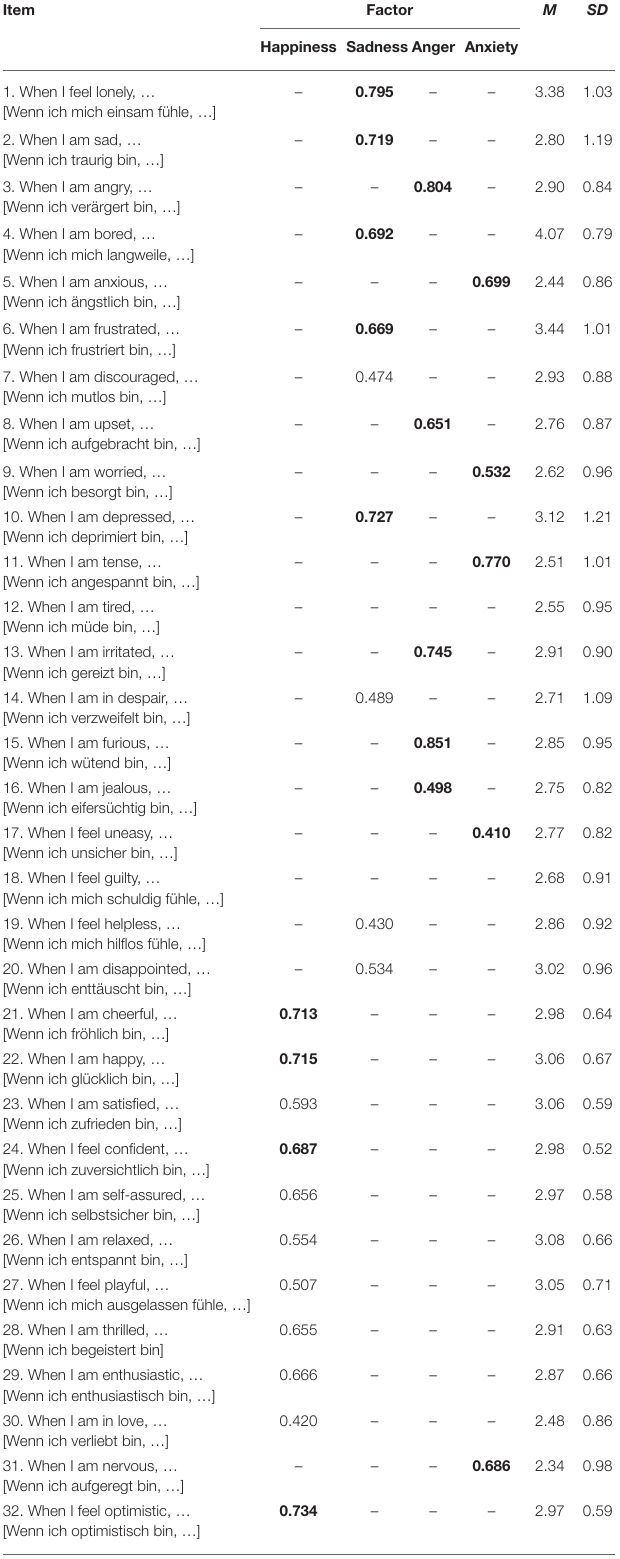
TABLE 1 | Factor loadings and item statistics in study